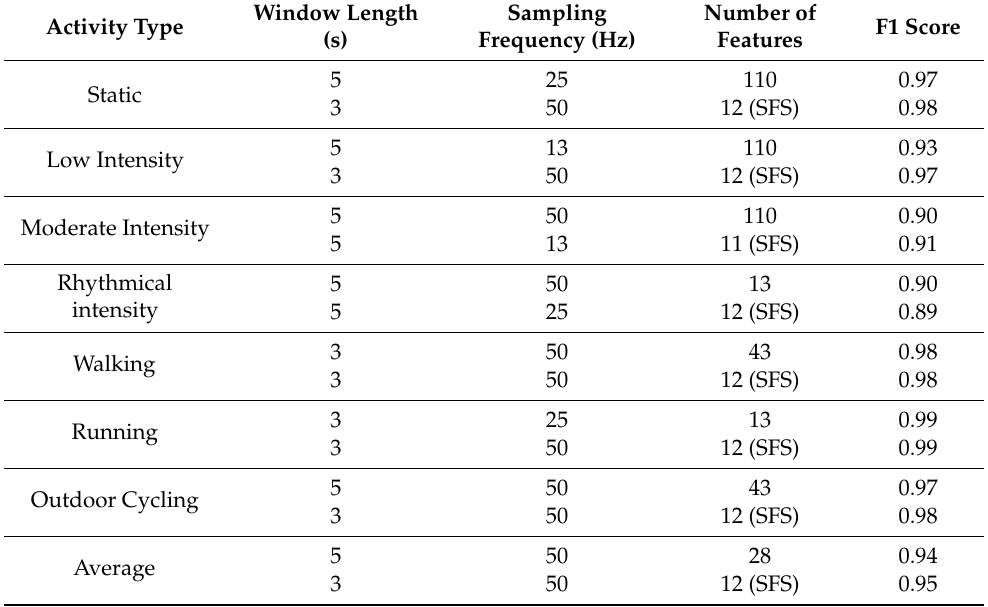
Table 4. Parameter combination with highest F1-score for di ff erent activity types and the average for both feature reduction